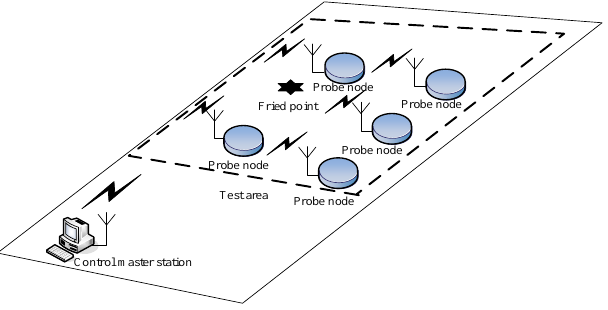
Figure 1. Schematic diagram of shallow ground distributed source localization.